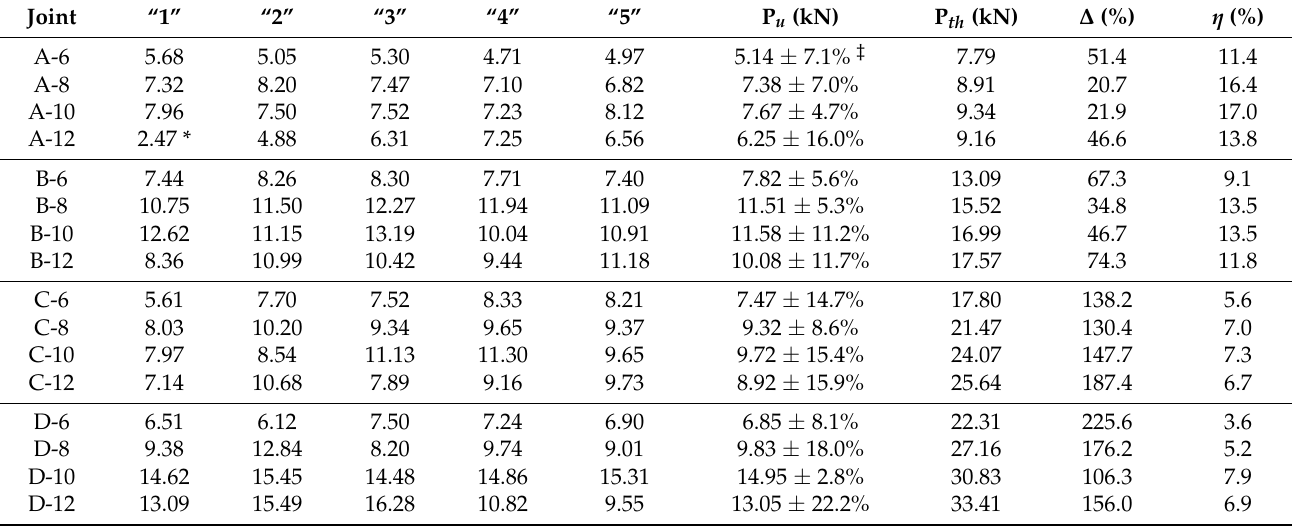
Table 5. The load-bearing capacity summary of all test specimens.